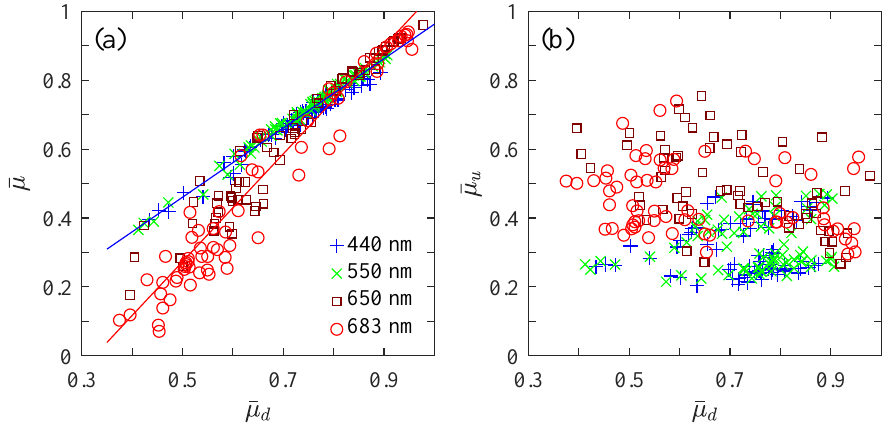
Figure 10. Relationships between average cosines based on measurements from all stations and depths. Data for ( a ) µ vs. µ and ( b ) µ vs. µ are shown for selected light wavelengths as indicated in panel d u d ( a ). In ( a ) data points for the blue and green (440 nm and 550 nm) were combined to determine the best-fit regression function (blue line) and data points for the red (650 nm and 683 nm) were combined to determine the best-fit regression function (red